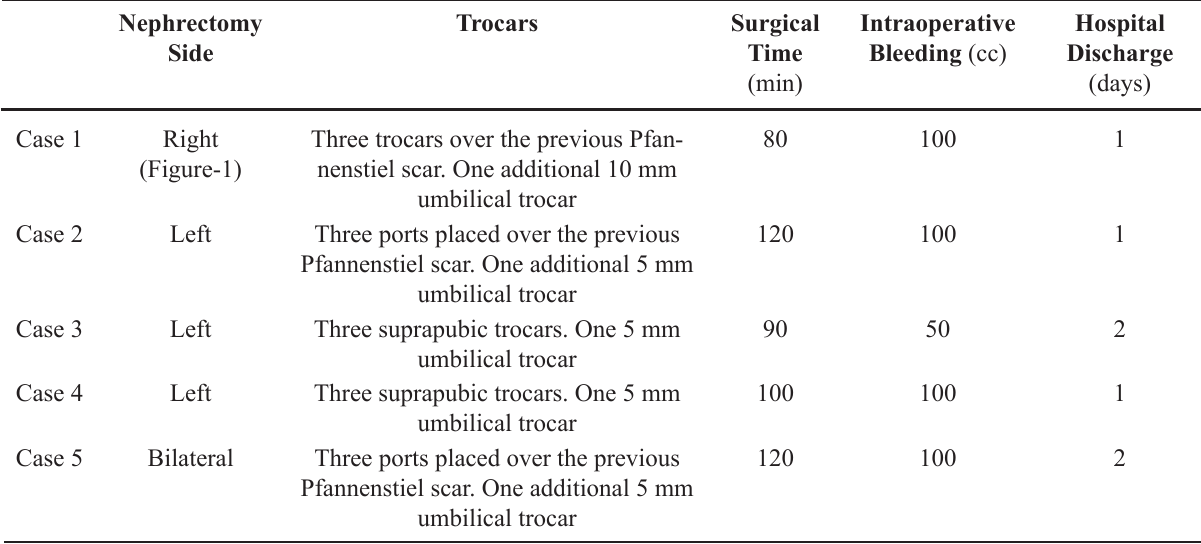
Table 2 – Intraoperative and early postoperative outcomes.